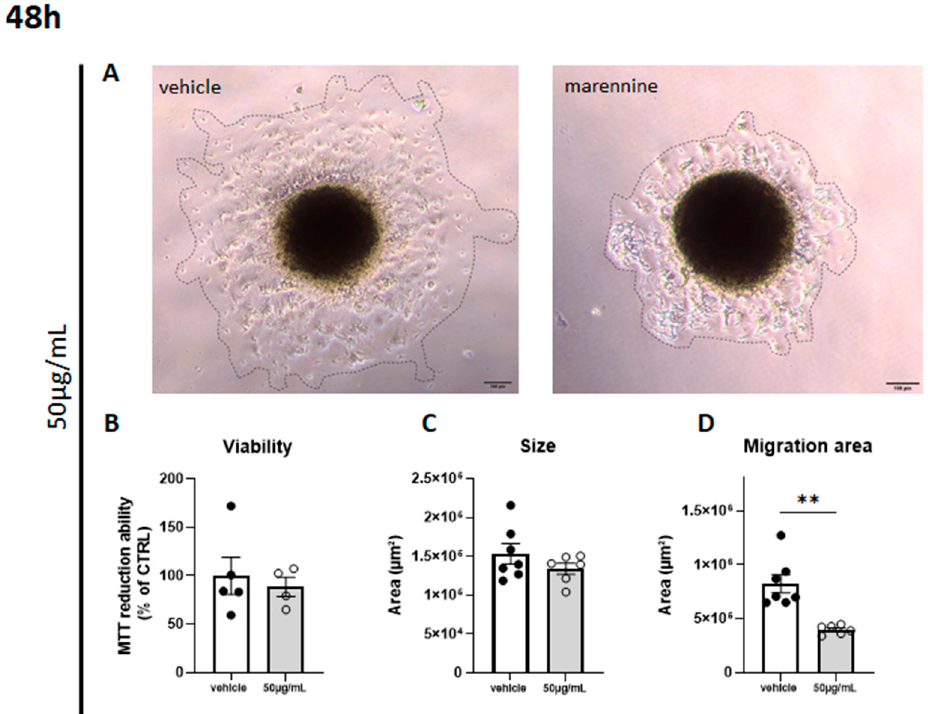
Figure 6. Effects of 50 µ g/mL marennine on cell migration after 48 h exposure. ( A ) Representative images were taken using a 10 × objective of a phase-contrast microscope; the outer dark circles in the phase-contrast images indicate the area covered by the migrated cells. ( B ) Cell viability was determined using MTT assay; vehicle n = 5, marennine n = 4. ( C ) Quantification of neurosphere size after migration; vehicle n = 7, marennine n = 6. ( D ) Quantification of the migration area covered by migrating cells from the core of the neurosphere; vehicle n = 7, marennine n = 6. Scale bar = 100 μ m. Values represent mean ± SEM. Significant differences from control are indicated: ** p < 0.01.